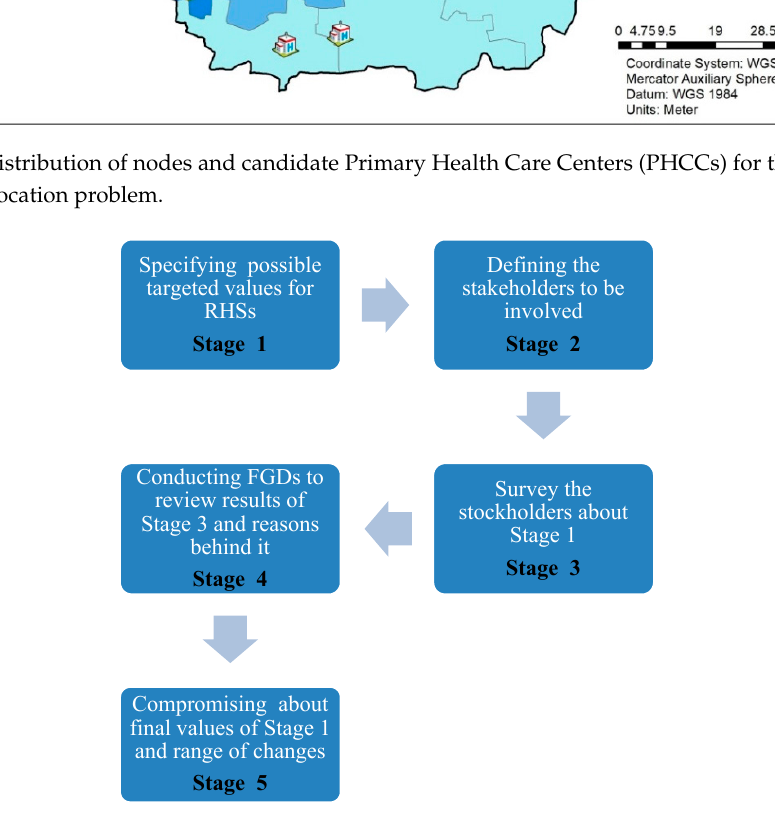
Figure 3. Flowchart of focus group discussions (FGDs)/surveys utilized in the study.